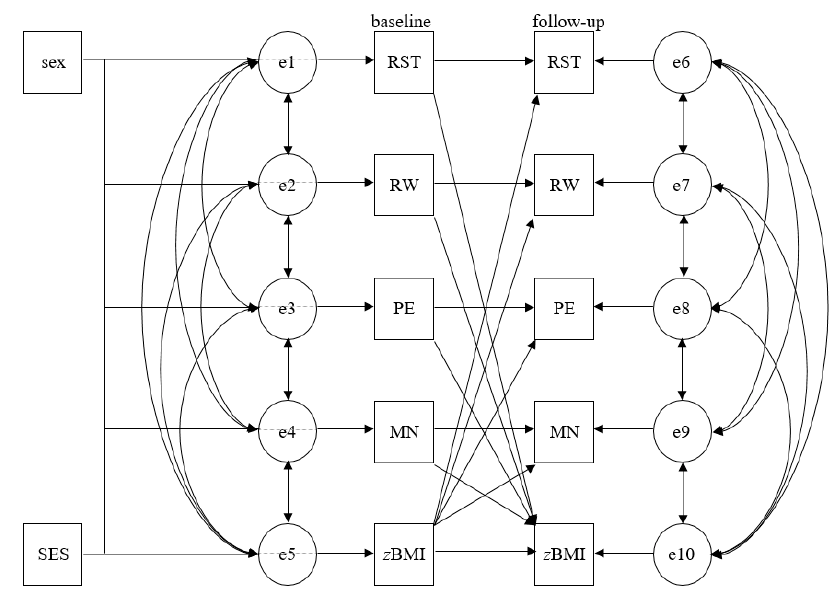
Figure 1. Cross-lagged panel analysis. sex—child sex; SES—socio-economic status; e—error term; RST—restrictive feeding; RW—food as reward; PE—pressure to eat; MN—monitoring; zBMI—standardized body mass index.